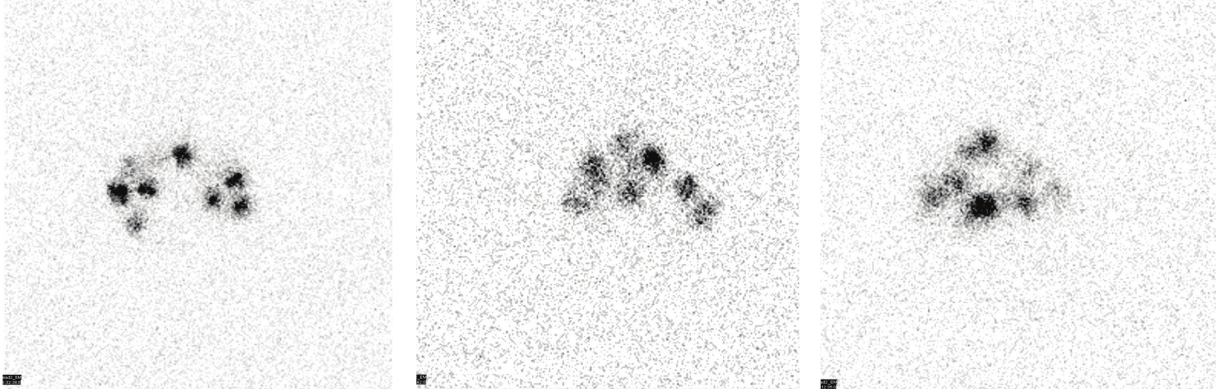
Figure 4: Gammagraphic images of the pregnant rats. There are deposits of 111In-oxine in the abdominal cavity in similar number to transplanted